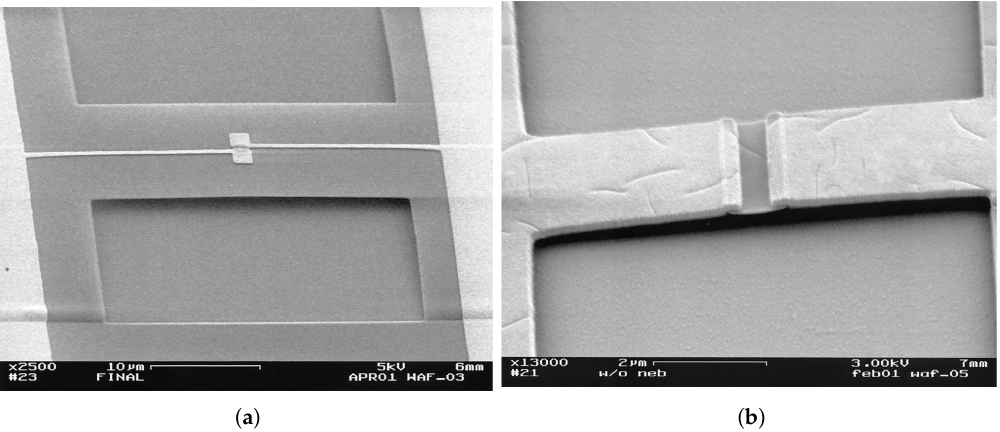
Figure 16. Air-bridge for isolation [45]: ( a ) Bolometer and antenna suspended on the air, ( b ) Suspended bolometer